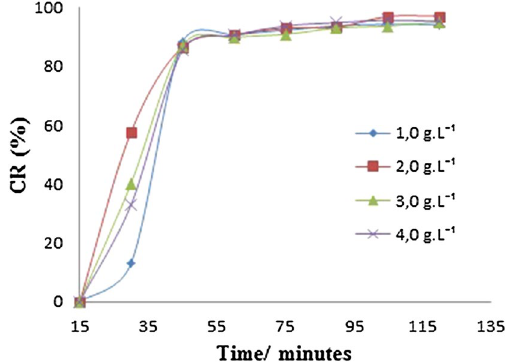
Fig. 6 Effect of the initial pH on the removal efficiency of Eri- ochrome Black 0.20 g L −1 . [NaCl] = 1.0 g L −1 ; electrolysis time = 60 min; and E = 7.0 V